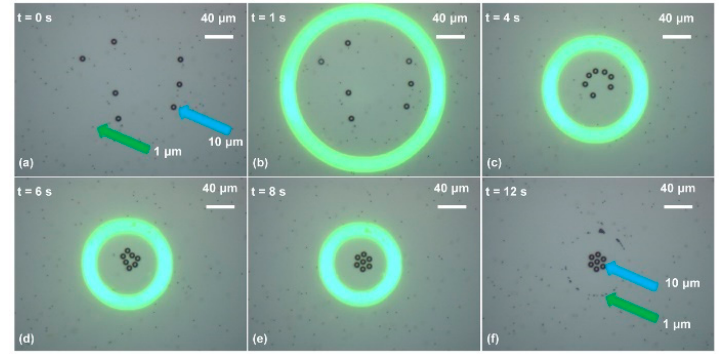
Figure 5. Separation of 10 μ m and 1 μ m polystyrene beads. ( a ) Initially, polystyrene beads were suspended in the liquid solution; ( b ) the OEK chip was illuminated by the optical ring pattern, with the AC bias potential switched on simultaneously; ( c ) 10 μ m polystyrene beads were pushed towards the central area of the ring under the action of a negative ODEP force, while the 1 μ m ones were attracted into the ring under the action of a positive ODEP force as the ring size decreased; ( d , e ) are captured images showing the positions of the polystyrene beads with two different diameters as the ring size decreased dynamically; ( f ) shows the final positions of the 10 μ m and 1 μ m polystyrene beads (reproduced from Ref. [42]).